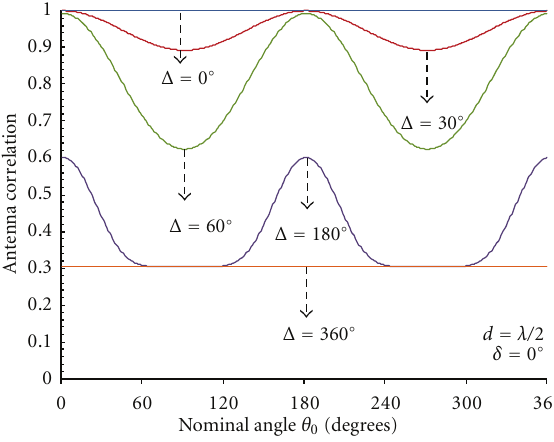
Figure 6: Relation between antenna correlation and θ 0